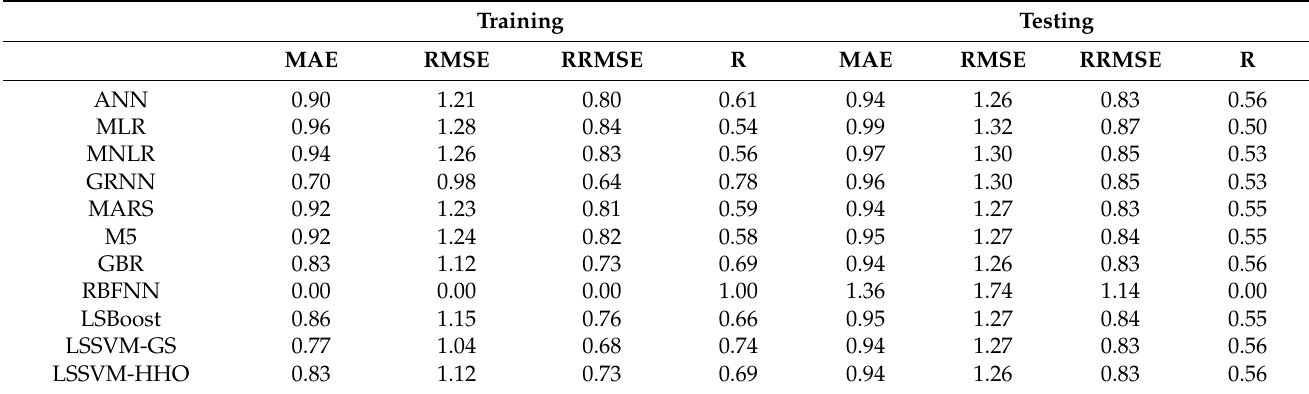
Table A8. Results of modeling WS with the base algorithms at the Qaen station.